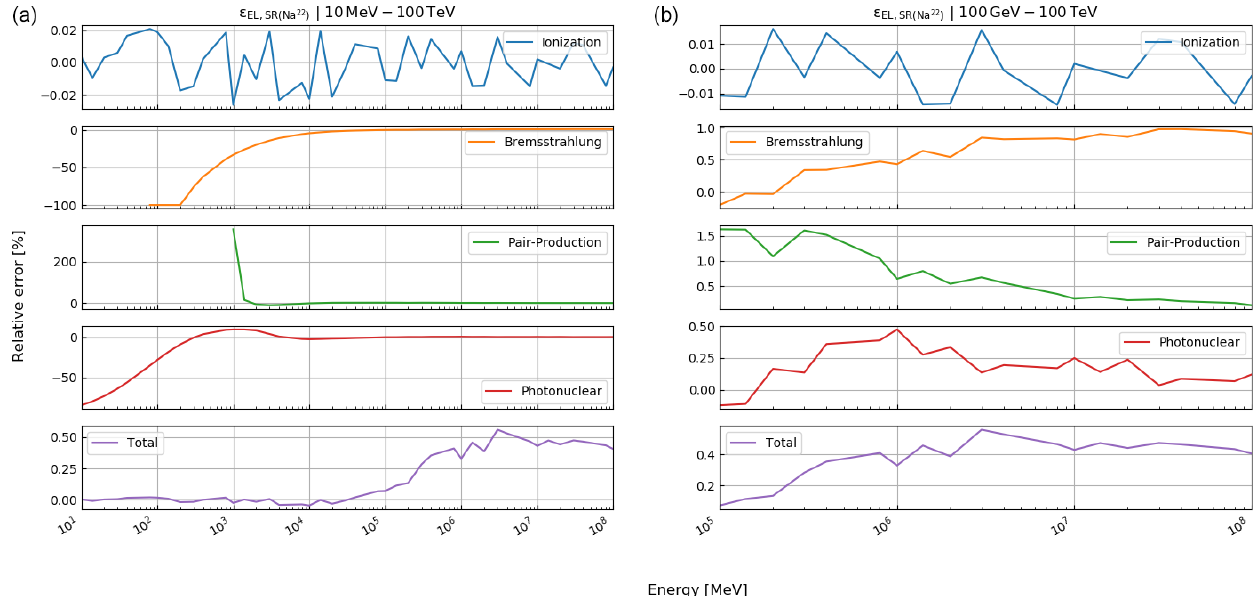
Figure E5. Relative error of our energy loss calculations compared to the tabulated values from Groom et al. (2001) for standard rock ( 22 in the energy ranges (a) 10MeV–100TeV and (b) 100GeV–100TeV.